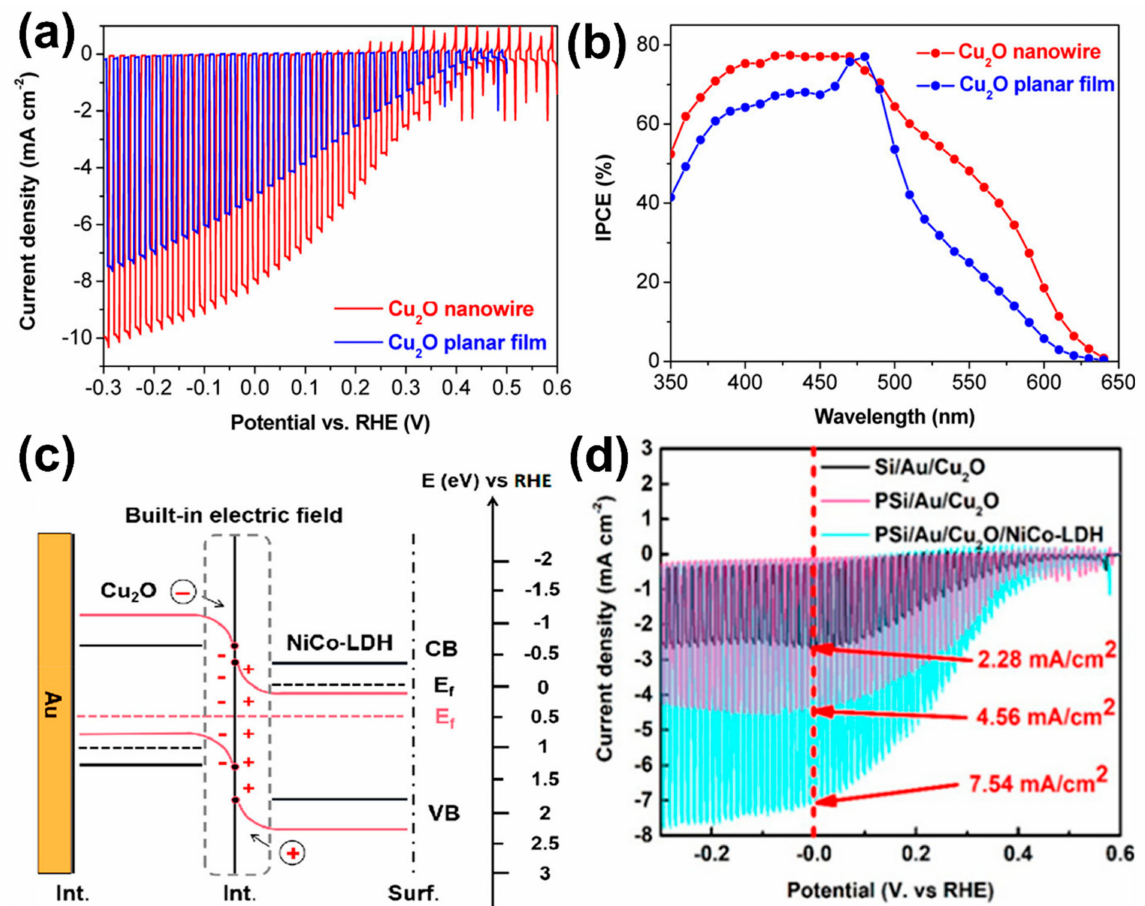
Figure 4. ( a ) J − V curves under the simulated AM 1.5G chopped illumination; ( b ) IPCE spectra under the monochromatic illumination of Cu 2 O NW and planar devices. Reproduced with the permission of ref. [35]. Copyright 2016, American Chemical Society. ( c ) energy band alignment diagram of the Cu 2 O/NiCo-LDH type-II heterojunction; ( d ) J–V curves of the fabricated photocathodes. Reproduced with the permission of ref. [37]. Copyright 2022, American Chemical